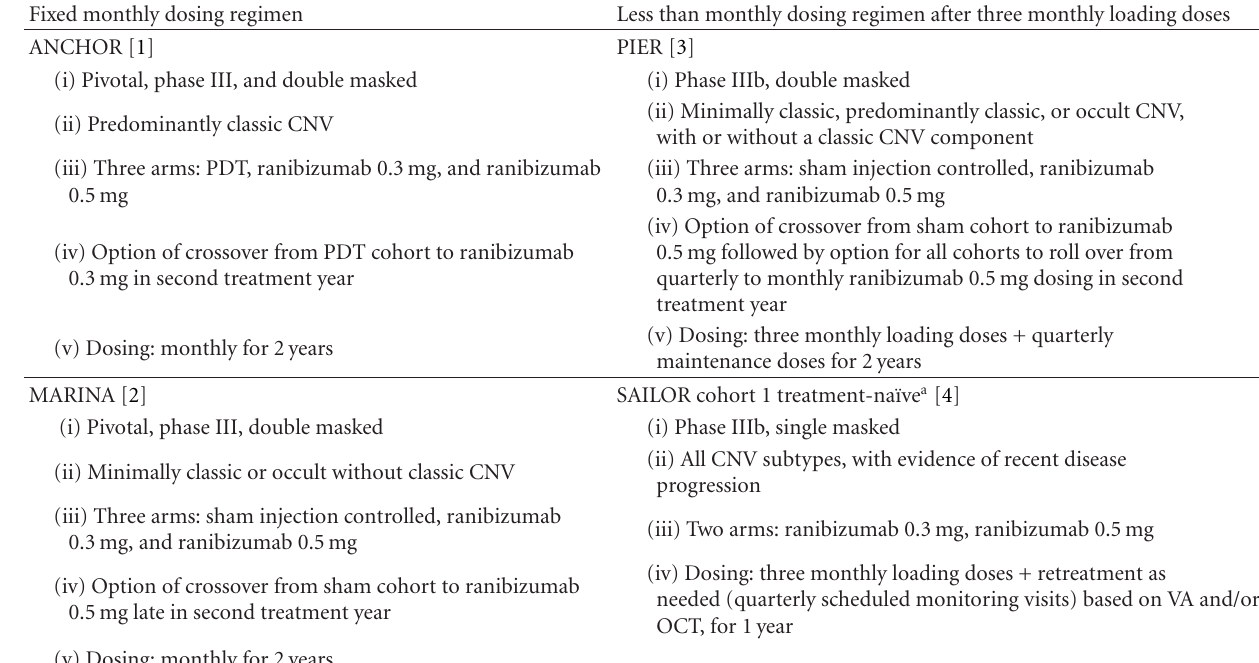
Table 1: Clinical trial designs.